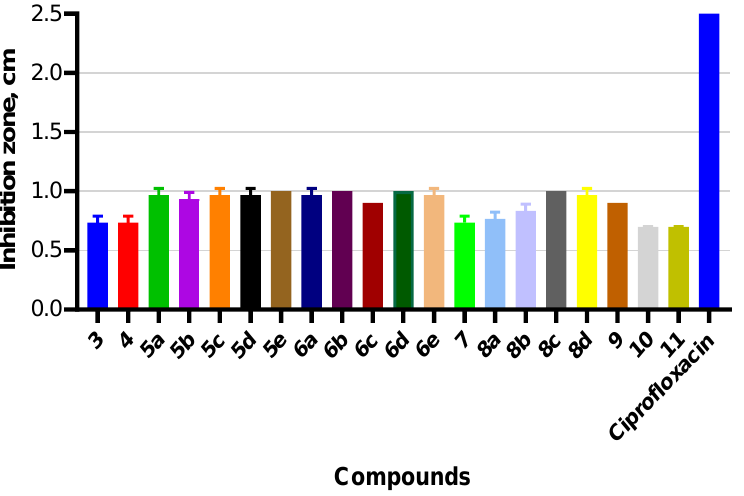
Figure 6. Antibacterial activity against E. coli of compounds 3 – 11 and control antibiotic Ciprofloxacin. Data are shown as mean ± SD from three experimental replicates.